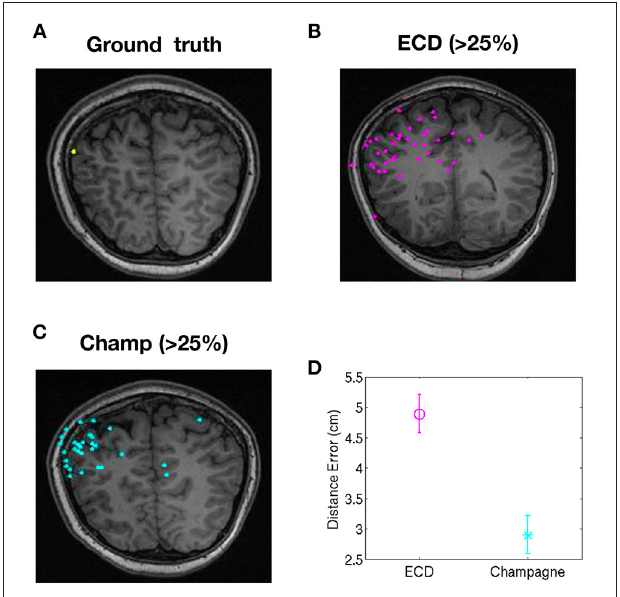
FIGURE 4 | Localization of high-error spikes by ECDss and Champagne algorithms: Subject 15. (A) Ground truth as defined by localizations of spikes by ECDss with errors < 10%. (B) Localizations of spikes by ECDss with error > 25% (C) Localization results when spikes with error > 25% by ECDss were then localized using the Champagne algorithm. (D) Distance between the ground truth (A) and the localization result by ECDss (B) and Champagne (C) for those spikes with ECDss error > 25%. For (D) , whiskers indicate SEM.